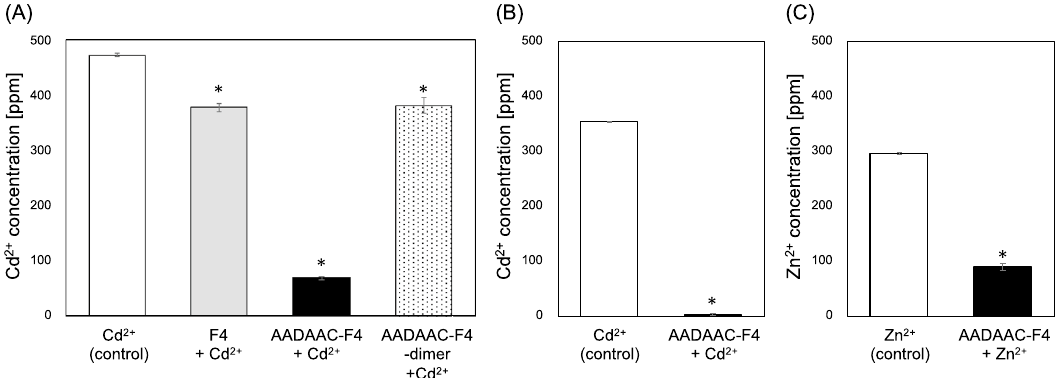
Figure 3. Metal binding affinity of AADAAC-F4 analogues. ( A ) Concentration of Cd 2+ in the supernatant of the CdCl 2 solution (4.26 mM) measured after treatment with F4, AADAAC-F4, and AADAAC-F4-dimer at a concentration of 10 mg/mL. The concentration ratio of AADAAC-F4 and Cd 2+ was 1:1. ( B ) Concentration of Cd 2+ in the supernatant of the CdCl 2 solution (3.19 mM) measured after treatment with 10 mg/mL (4.26 mM) of AADAAC-F4. The concentration ratio of AADAAC-F4 and Cd 2+ was 1.3:1. ( C ) Concentration of Zn 2+ in the supernatant of the ZnCl 2 solution (4.26 mM) measured after treatment with 10 mg/mL (4.26 mM) of AADAAC-F4. The concentration ratio of AADAAC-F4 and Zn 2+ was 1:1. * P < 0.05 in a t -test between the concentration after treatment with each peptide compared to that of the control in each graph. Concentration of peptides Concentration of metal ion Removal